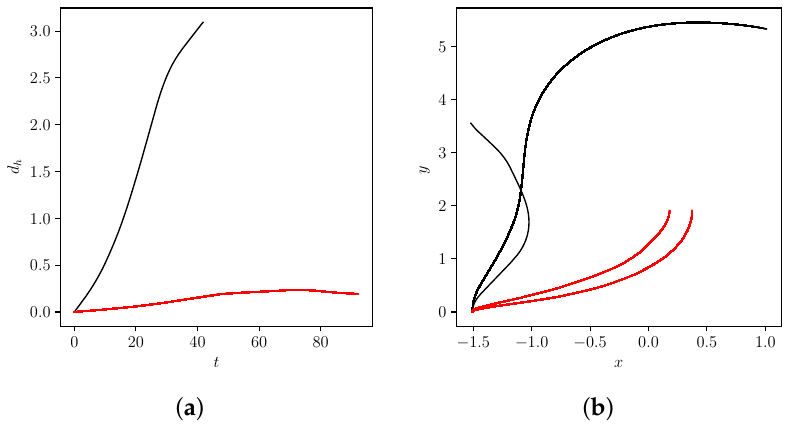
Figure 17. ( a ) horizontal distance between the vortex centres d h versus time t for case 6.1 (wide filament, black) and case 6.3 (thin filament, red); ( b ) trajectories of the vortex centres (same colour coding).